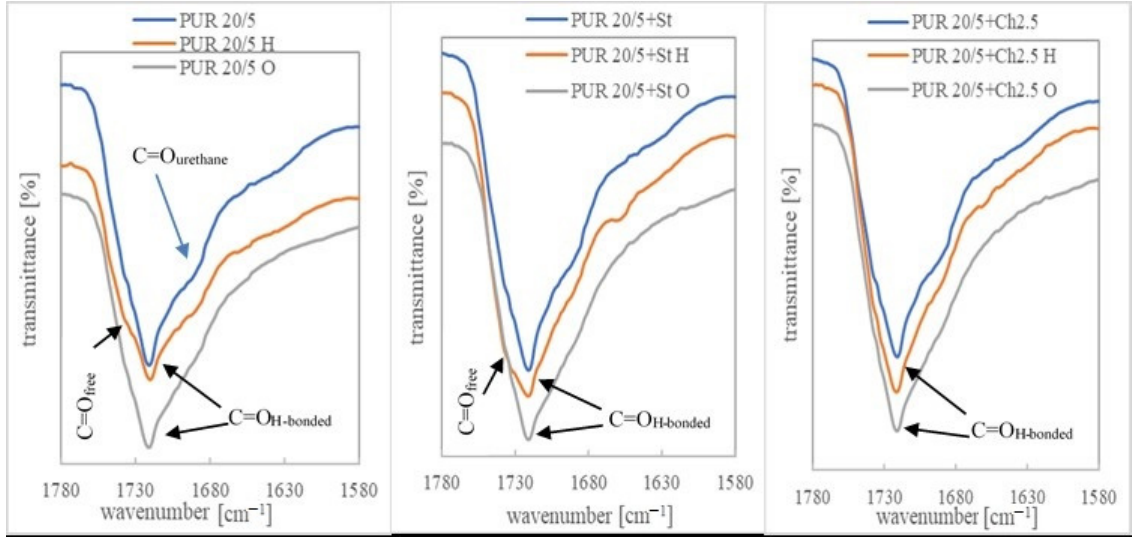
Figure 5. ATR-FTIR spectra in the range 1580-1780 cm − 1 of PUR 20/5, PUR 20/5+St and PUR 20/5+Ch2.5, before and after degradation in hydrolytic (36 weeks) and oxidizing (1 week) solutions.